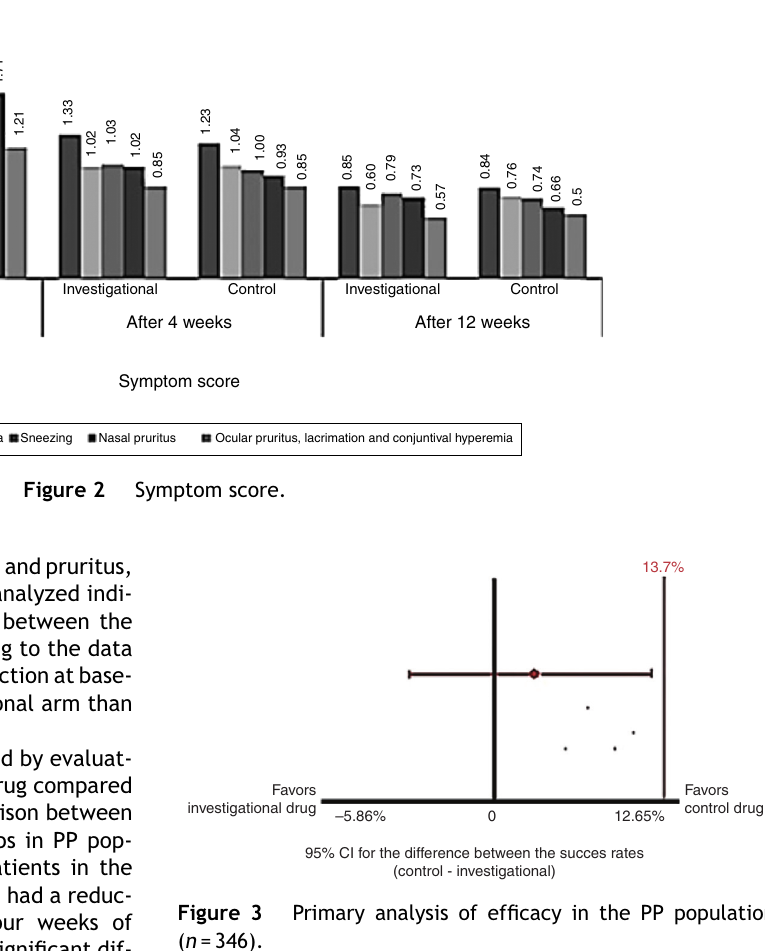
respectively. The group treated with the control drug showed a NIS score of 5.51 ± 1.36; 3.24 ± 2.07; and 2.34 ± 1.91 before treatment and after four and 12 weeks of treatment, respectively (Fig. 4).